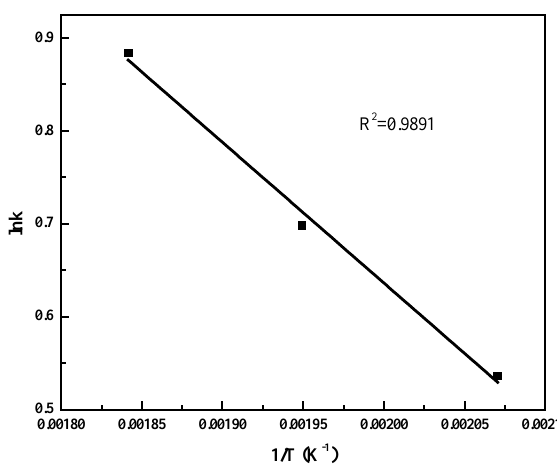
Figure 10. Arrhenius plot-based on LH model for FT synthesis over CoRu-KIT-6 catalyst.